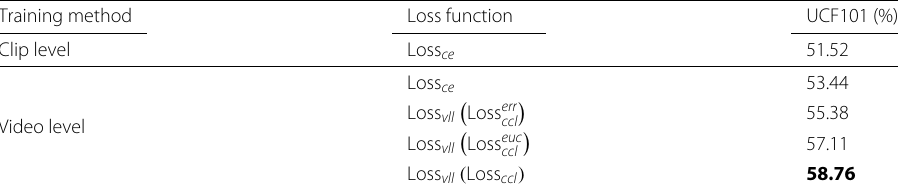
Table 1 Accuracy of clip-level training and video-level training with different loss functions Training